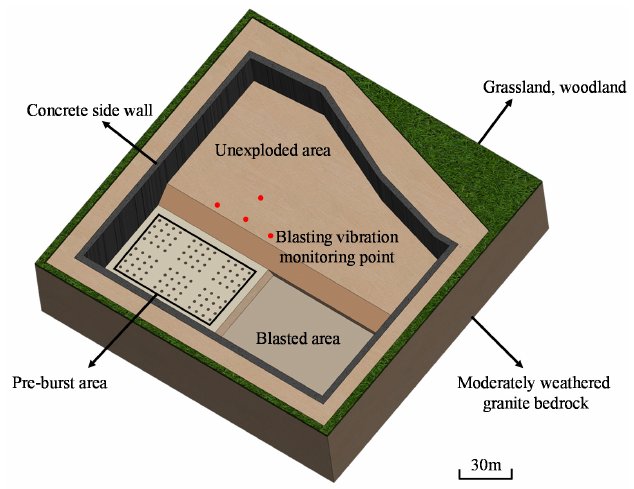
Figure 1. The schematic diagram of the project site and monitoring points.